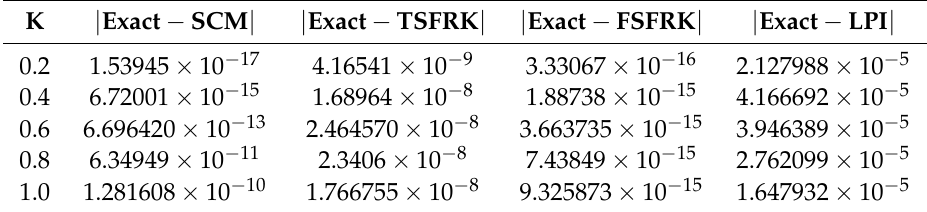
Table 1. The absolute error between the exact solution (6) and the numerical solutions by spectral collocation method (SCM), two-stage fractional Runge–Kutta (TSFR), four-stage fractional Runge–Kutta (FSFRK), and Lagrange polynomial interpolation (LPI), respectively, for ν = 1, ζ = 5, h = 0.003, m = 21 with different values of K .